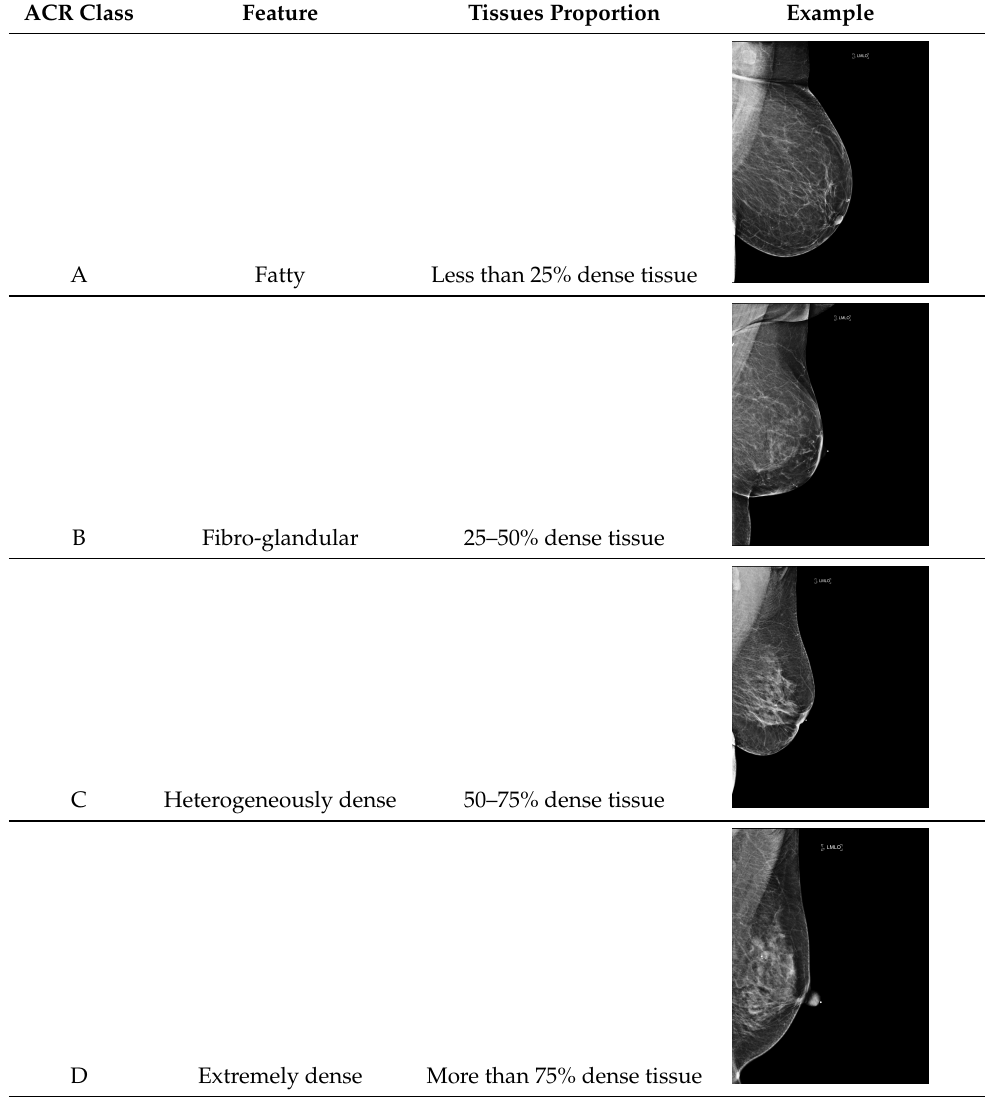
Table 1. Breast density